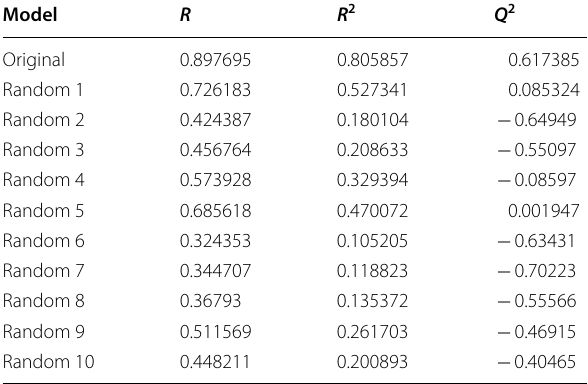
Table 6 Y-randomization parameters test